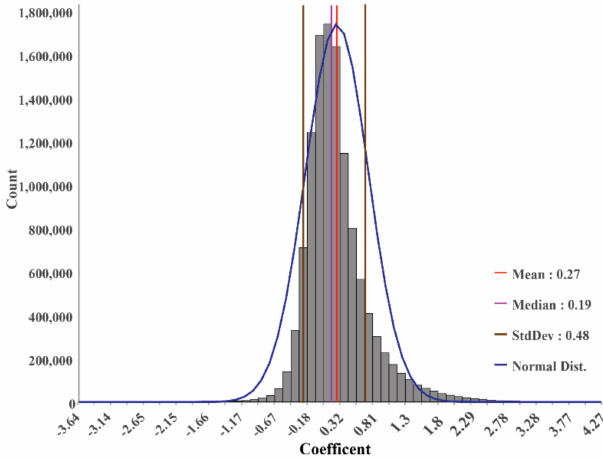
Figure 3. Regression coe ffi cient histogram of global stable lighting